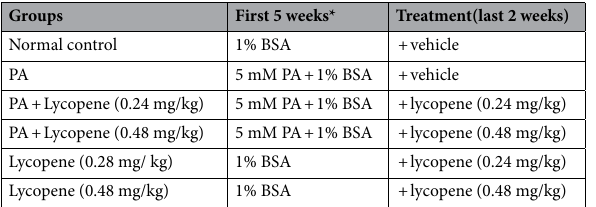
Table 1. Experimental design. * The respective PA and/or BSA administration lasted throughout the study; BSA = Bovine serum albumin; PA = palmitic acid; vehicle = olive